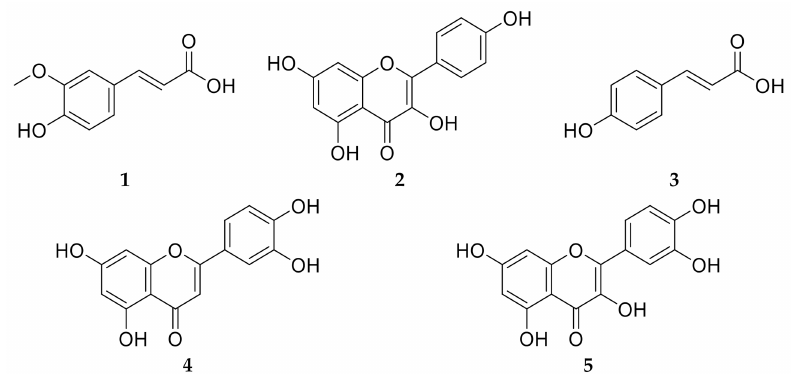
Figure 7. Chemical structures of the isolated compounds 1 – 5 from C. annua ethyl acetate fraction. Compound 1 is ferulic acid, compound 2 is kaempferol, compound 3 is p -coumaric acid, compound 4 is luteolin and compound 5 is